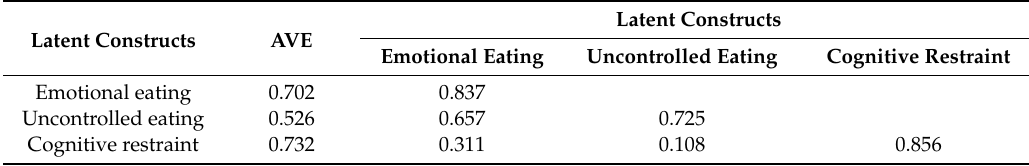
Table 11. Results of di ff erence